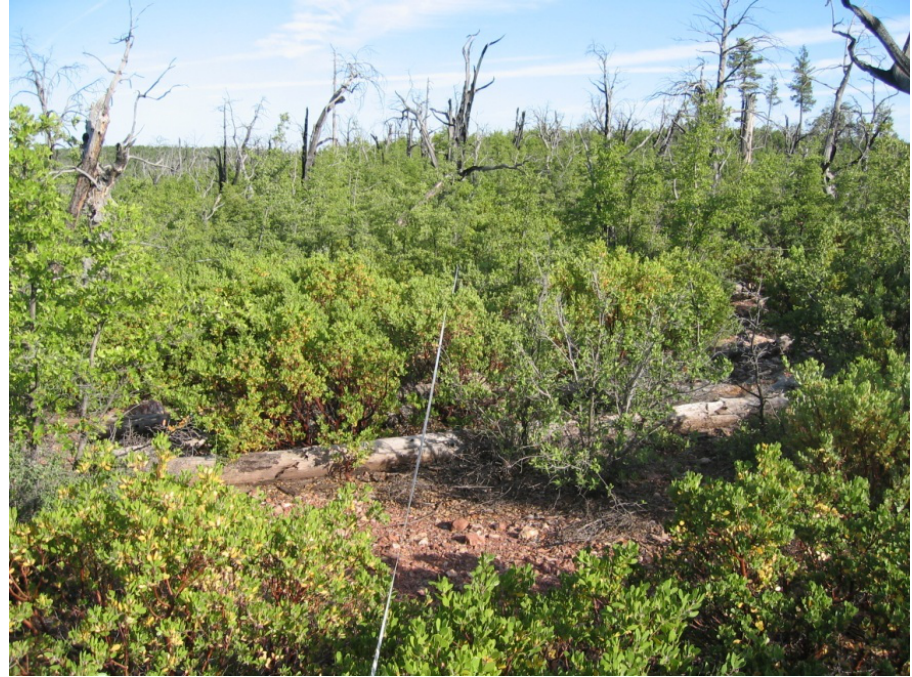
Figure 3. Transect established in 2005 on the area burned by the Dude Fire of 1990. Each sampling plot consisted of a 40 m center line over which a microplot was established at each meter mark. Macroplots were established by measuring 5 m from the 40 m centerline and then 8 m parallel to the line. Herbaceous plant cover for each species and ground cover (e.g., bare soil, rock, litter) estimates were recorded at each of the 0.1 m 2 microplots and reported as a percentage of the total area within each microplot. Cover classes were used to estimate ground cover [35]. Plant frequency and species richness were determined from plot data. At each of ten 5 × 8 m macroplots, woody plant density was estimated. The presence and number of each woody species within the macroplot were measured. Plot densities were converted to stems per hectare values for each species. In addition to the vegetation data, GPS location, slope, and bearing data were recorded on all transects. Soils were extensively sampled ten years after the fire on 14 burned sites (5 limestone sites